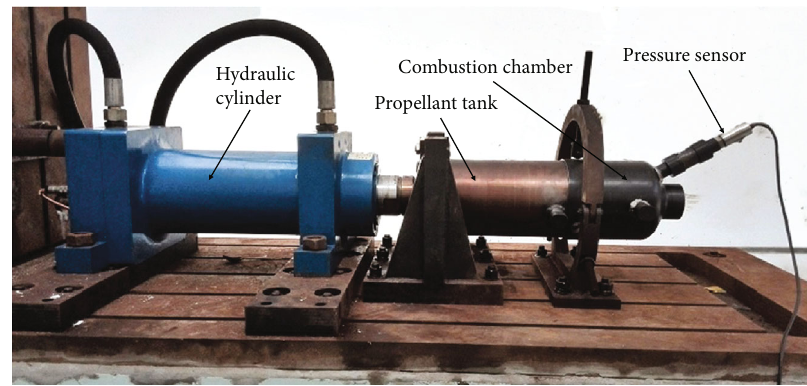
Figure 7: Photographic view of the pasty rocket engine test system.